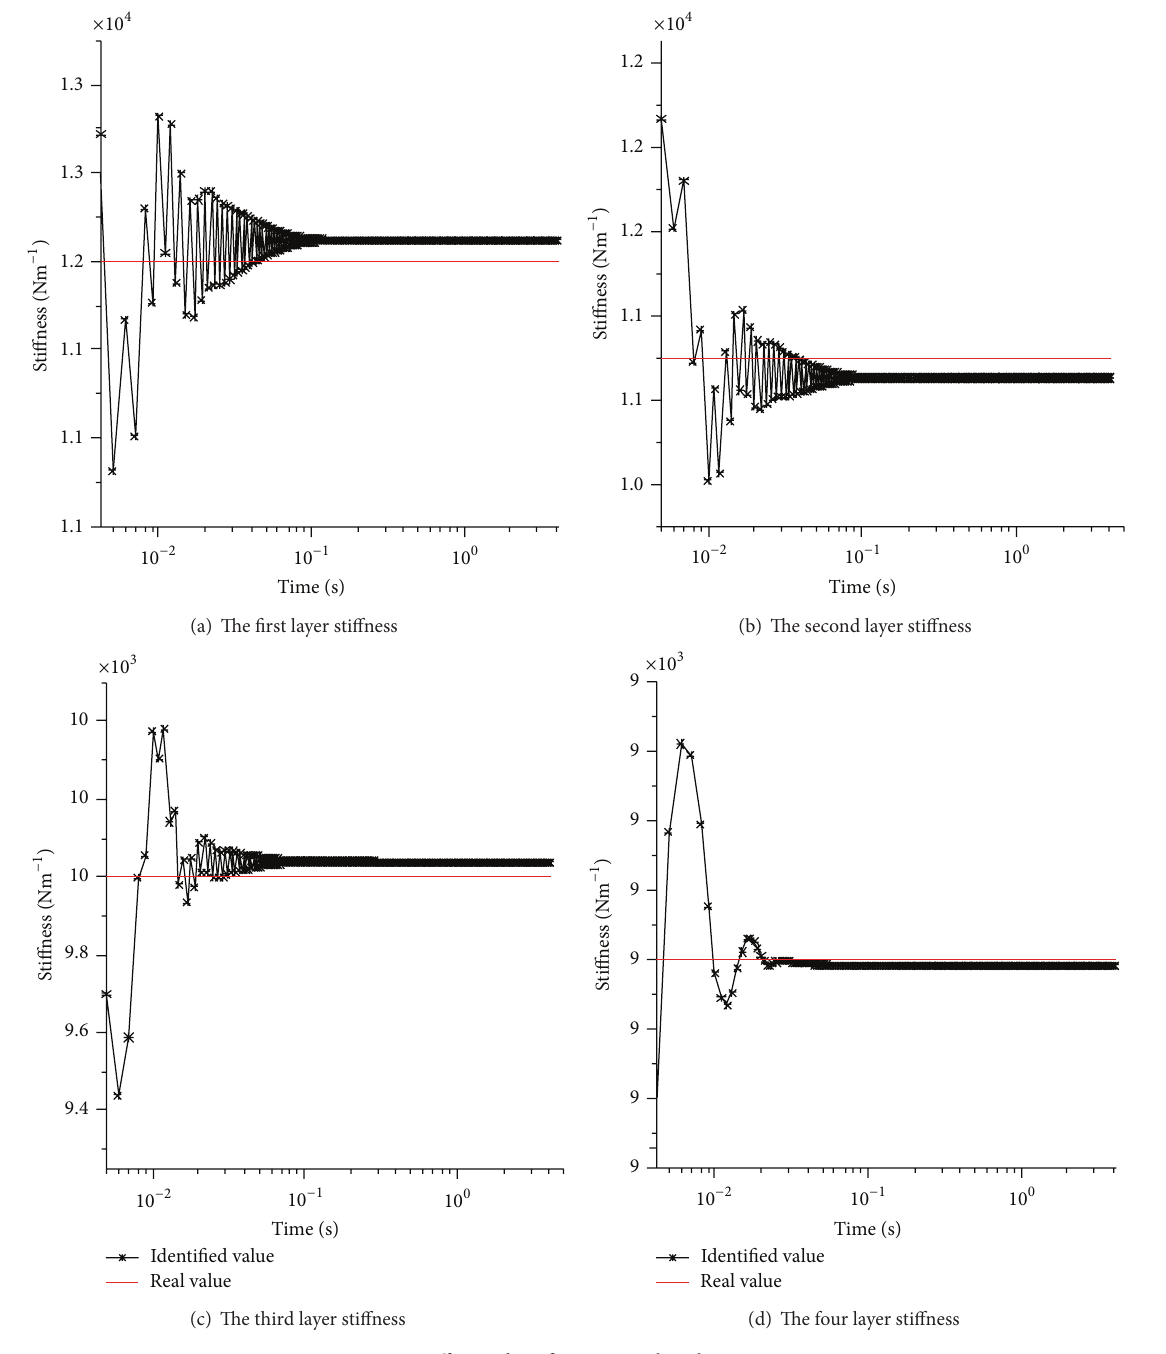
Figure 3: Stiffness identification results when SNR is